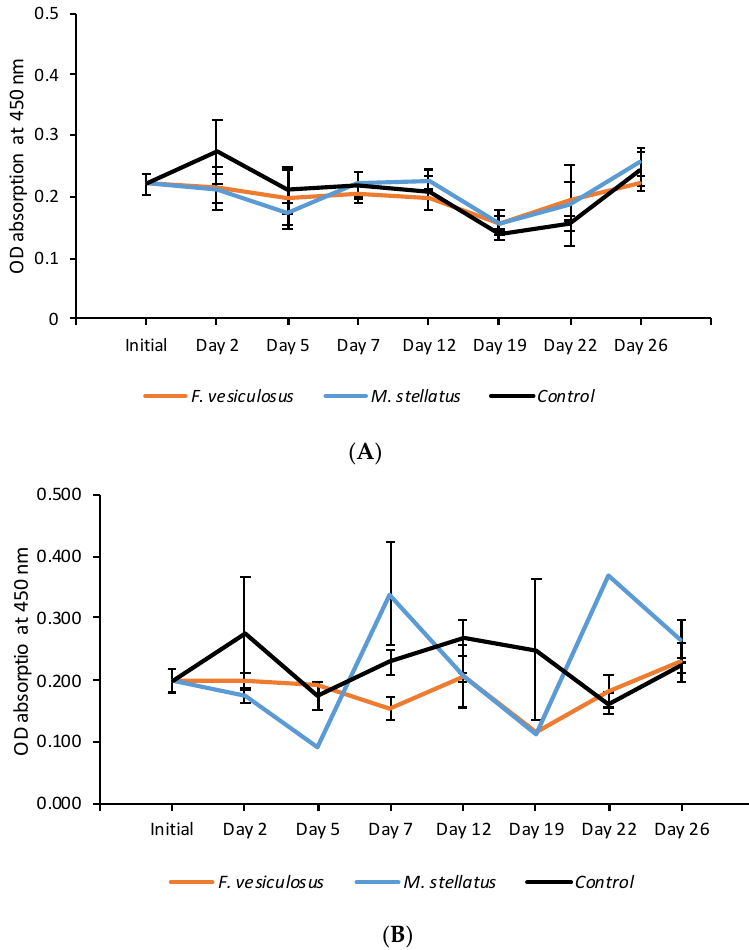
Figure 4. Lysozyme amount for ( A ) uninfected and ( B ) OsHV - 1 μ Var infected oysters based on average (+ SE ) OD absorbance . A low value indicates a high blood lysozyme amount and a high value indicates a low blood lysozyme amount .